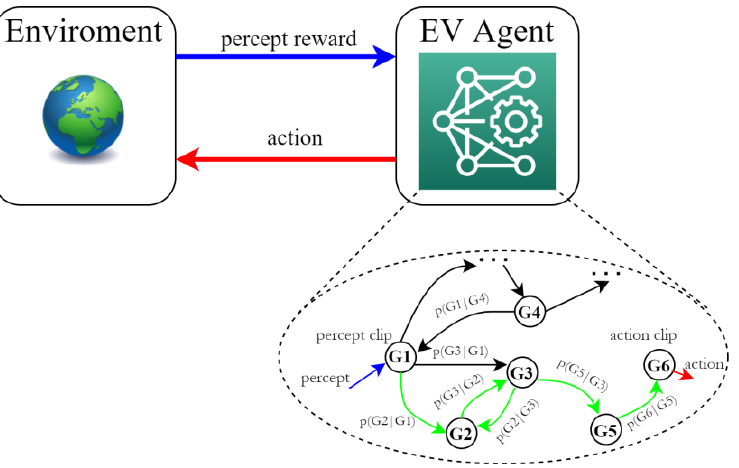
Figure 1. Learning process in the RL (environment) algorithm.